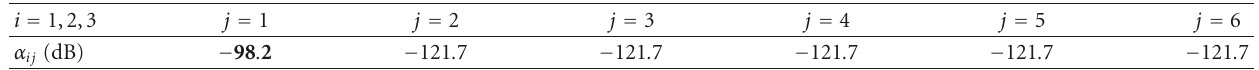
Table 2: Path loss coe ffi cients